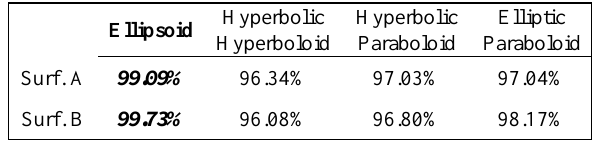
Table 3. Statistical correlation ratio 𝛿 .